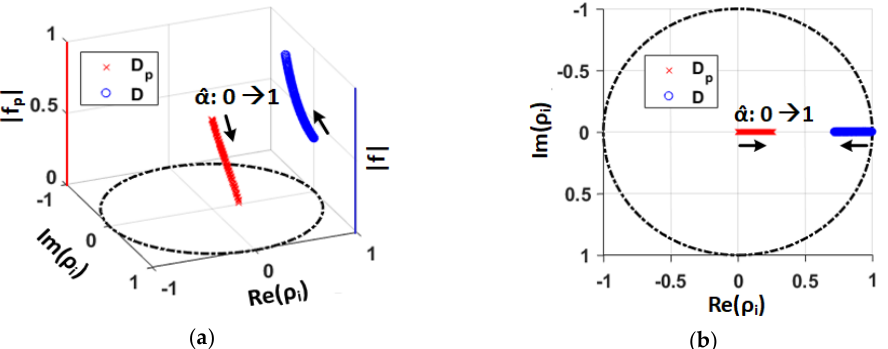
Figure 4. Pole behavior of the biexponential model for uniformly spaced b values of b = 0, 1, 2, 3 and 𝐷 𝑠𝑒 = 1/𝑏 𝑚𝑎𝑥 ; ( b ) is the top view of ( a ). The red trajectory is associated with the pole ( 𝜌 1 = 𝑒 −𝐷 𝑝 ) that corresponds to the pseudo-diffusion with amplitude 𝑓 𝑝 and the blue trajectory is associated with the pole ( 𝜌 2 = 𝑒 −𝐷 ) that corresponds to the true diffusion with amplitude 𝑓 . The arrows indicate the direction of the pole trajectory as 𝛼 ̂ increases from 0 + to 1.